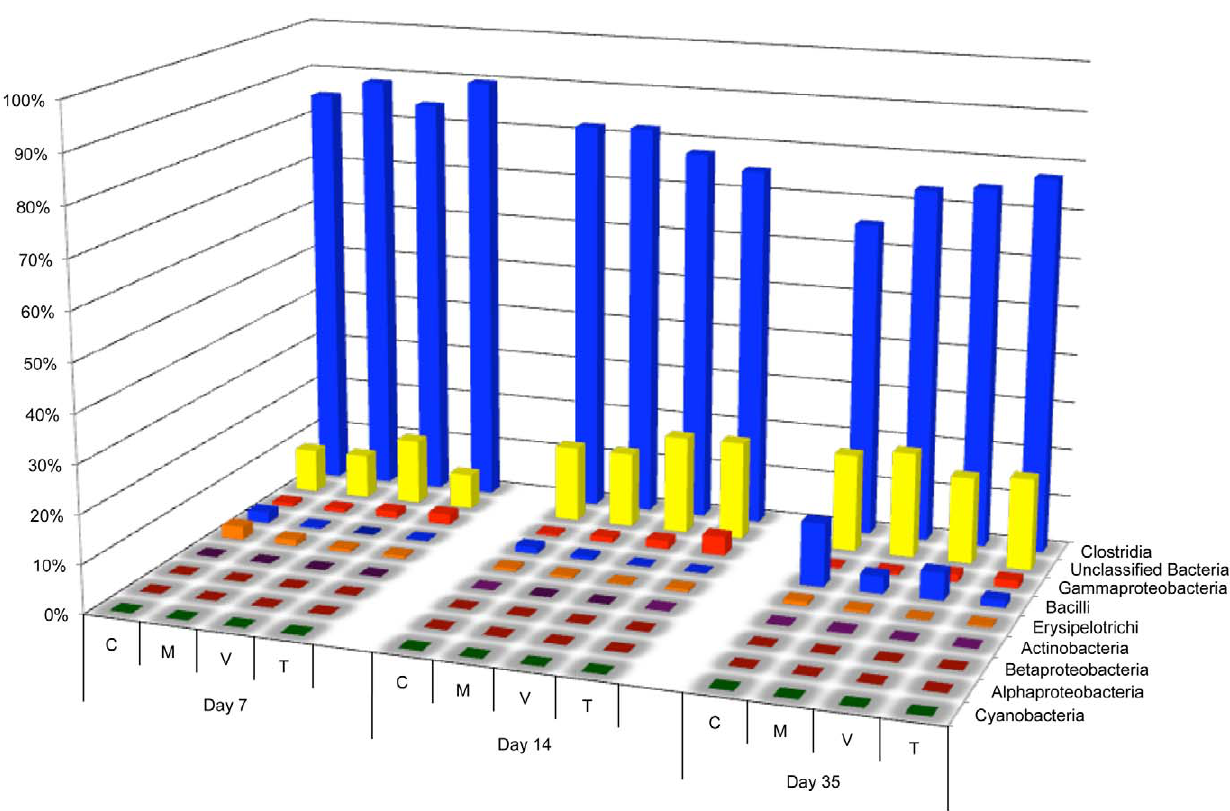
Figure 2. Bacterial class distributions among the three timepoints after the start of treatments, using V3 amplicon sequencing (n=89,652). For each timepoint, C = control diet, M = monensin treatment, V = monensin/virginiamycin treatment, and T = monensin/tylosin treatment.